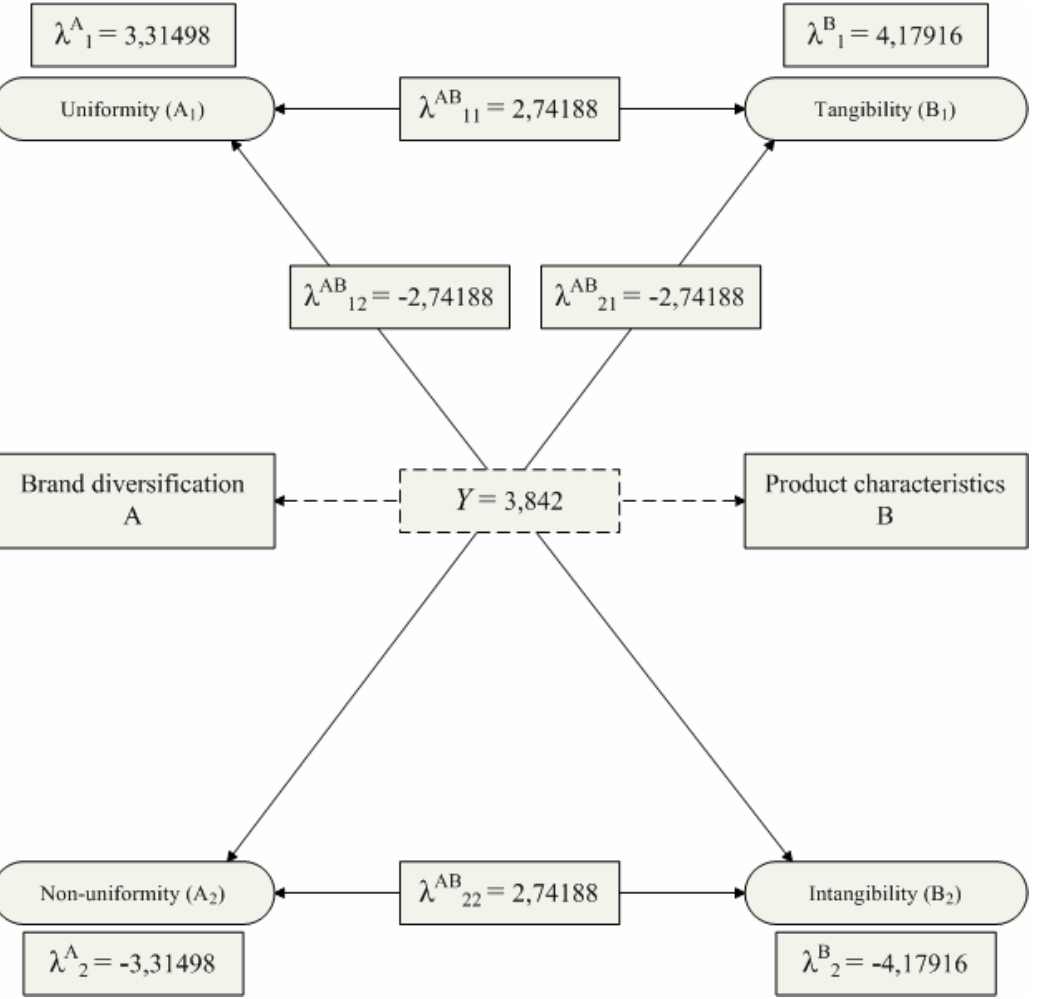
Figure 7 Data network displaying relative factor (brand transmutation and product characteristics) values of the satisfied log linear